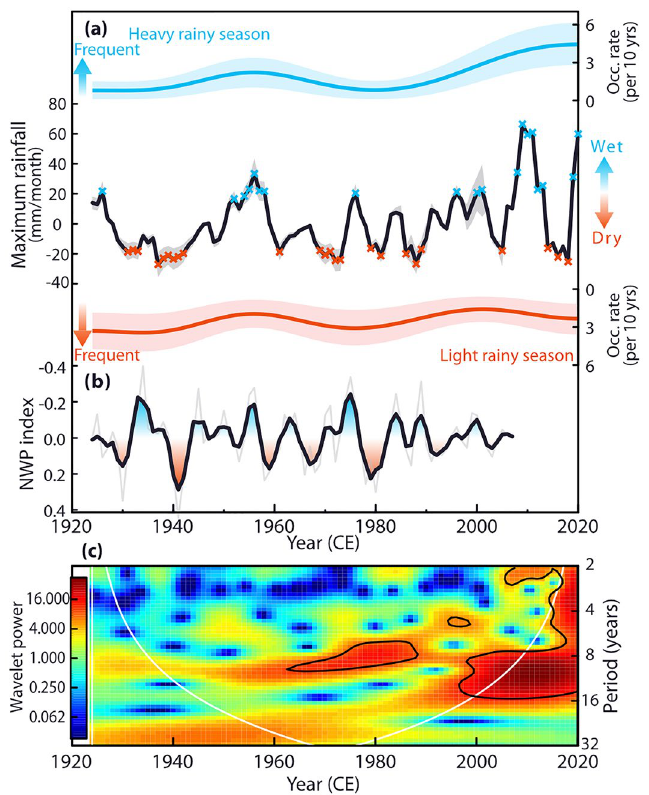
Figure 2. Time series analysis of the maximum rainfall. ( a ) The maximum rainfall recon+GPCP (black line) derived from the min-δ 18 O sw and rainfall GPCP . Grey shades indicate the 90% confidence intervals of maximum rainfall reconstruction. Cross plots indicate the year with the heavy (blue) or light (red) rainy season. Note that rainfall in the heavy rainy season (blue cross plot) shows an increasing trend. The occurrence rates of heavy (blue line) and light (red line) rainy seasons are indicated above and below panel a, respectively. Light-coloured shades indicate the 90% confidence bands of occurrence rates. ( b ) The NWP index 18 (thin and thick lines: annual and 3-year moving averaged data). ( c ) A Morlet wavelet analysis for the maximum rainfall recon+GPCP . The solid black lines indicate a 95% confidence level. White lines show the cone of influence, where edge effects reduce the